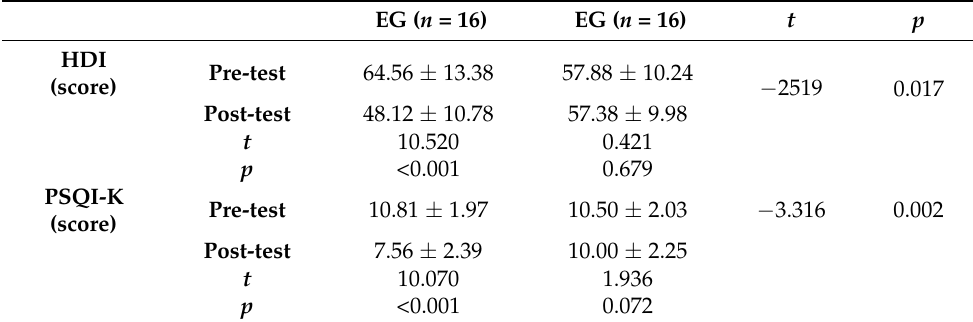
Table 2. Variations in headache and sleep disorder ( n =